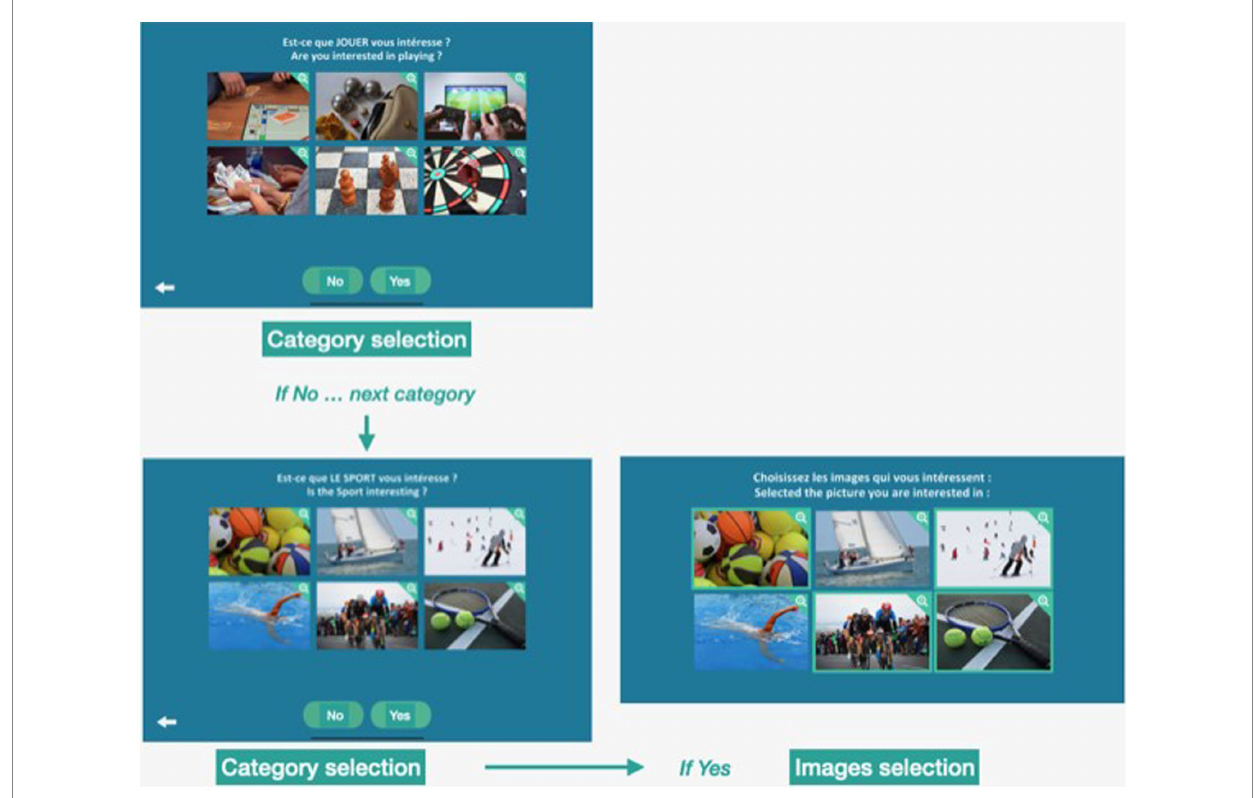
FIGURE 1 Interest game. Screenshots of the Interest game. First, participants are asked if they are interested in a specific category (e.g., playing). If they respond “No,” they go directly to the next category (e.g., sports). If they respond “Yes,” they are asked to select up to six images of activities they are interested